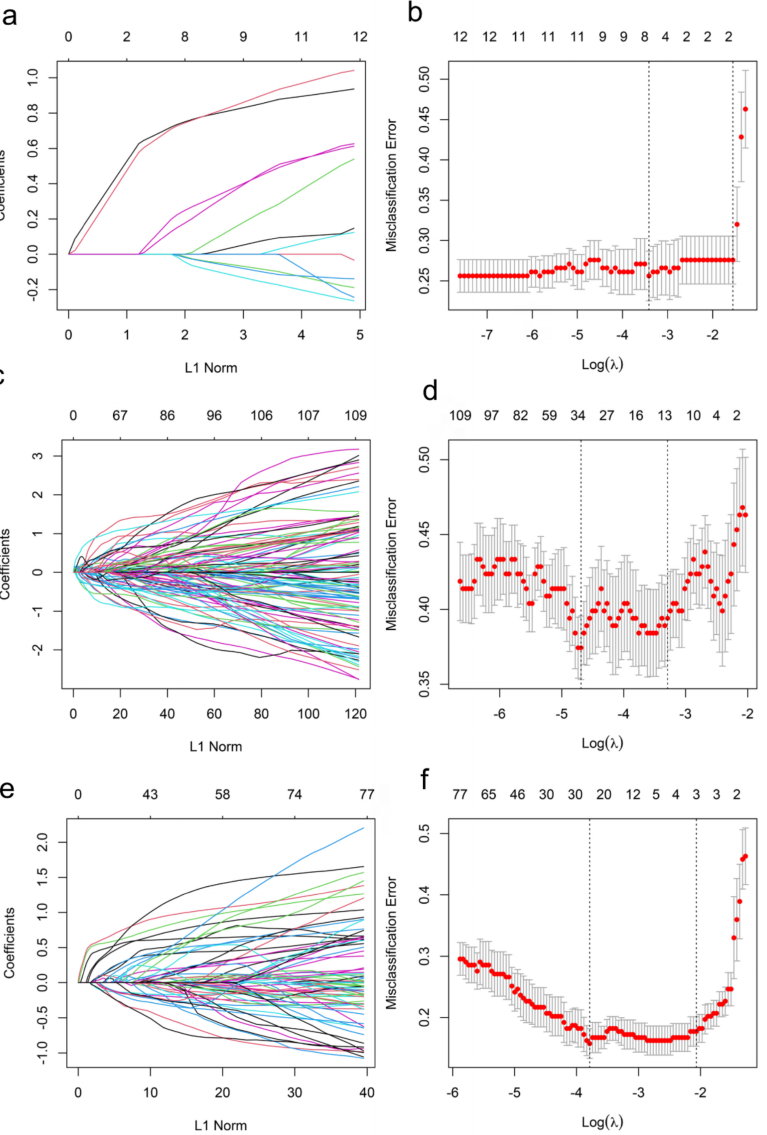
Figure 2. Features selection for the prediction of the models in the training set. ( a , c , e ) show the LASSO coefficient profiles of features. ( b , d , f ) show the feature selection by the LASSO model with tuning parameter ( λ ) using 10-fold cross-validation via minimum criteria. The X-axis shows log ( λ ), and the Y-axis shows the model misclassification rate. The dotted vertical lines are drawn at the optimal values using the minimum criteria and the 1-se criteria, respectively. The 7, 34, and 19 features with non-zero coefficients are initially indicated with the optimal λ values of 0.03, 0.01, 0.02 for Clinicopathologic Model ( b ), Radiomics Model ( d ), and Combined Model ( f ),